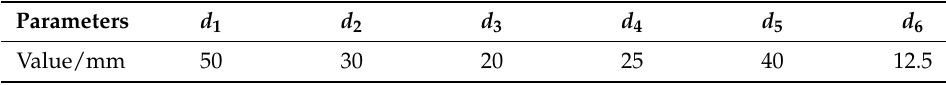
Table 1. Dimensions of bolt-sphere connections.